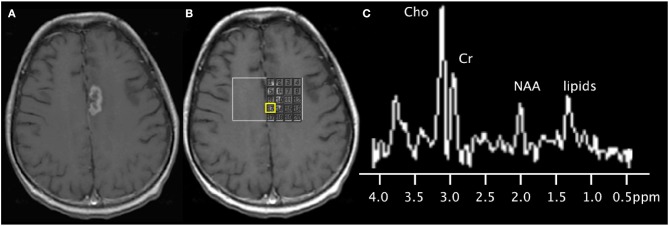
67-years-old patient with a left medial frontal lobe brain metastasis from primary lung cancer treated with stereotactic radiosurgery. (A) Post-contrast T1-weighted image shows the treated enhancing lesion. (B) Multi-voxel 2D magnetic resonance spectroscopy acquired at 3T with grid placed on the lesion. (C) Spectra (from the voxel highlighted in yellow) shows findings of disease progression, with the presence of a lipid peak (indicative of necrosis), high Cho peak, and increased Cho/NAA and Cho/Cr ratios. Subsequent short-term follow-up MRI showed growth of the lesion (not shown), supporting the diagnosis of disease progression.